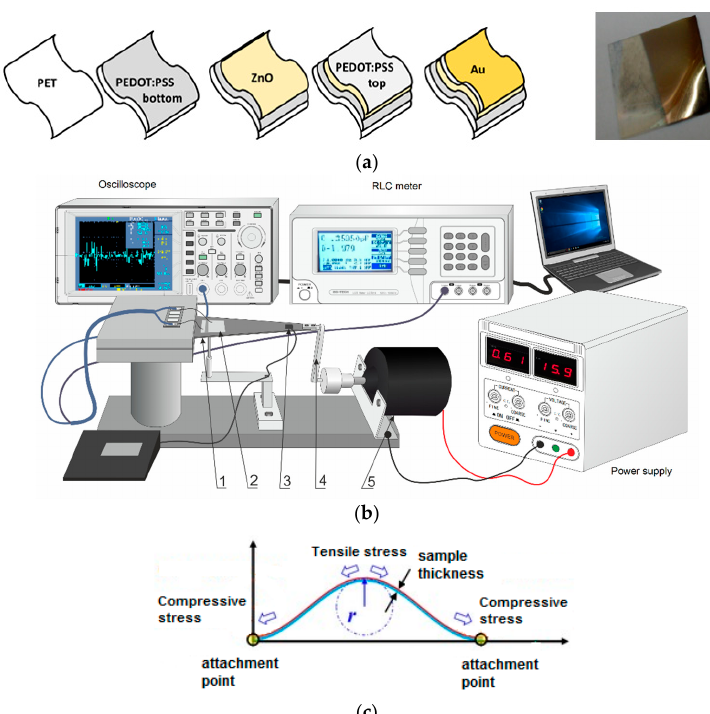
Figure 1. Schematics of ( a ) a layered configuration of the flexible polymer-based piezoelectric harvester ( left ) and photo of the sample ( right ); ( b ) lab-made combined vibrational setup and cyclic bend tester (1—beam, 2—sample under test, 3—weight detector, 4—tiller bending the beam, 5— electromotor activating the tiller); ( c ) sample configuration at static bent conditions with a certain radius of curvature.